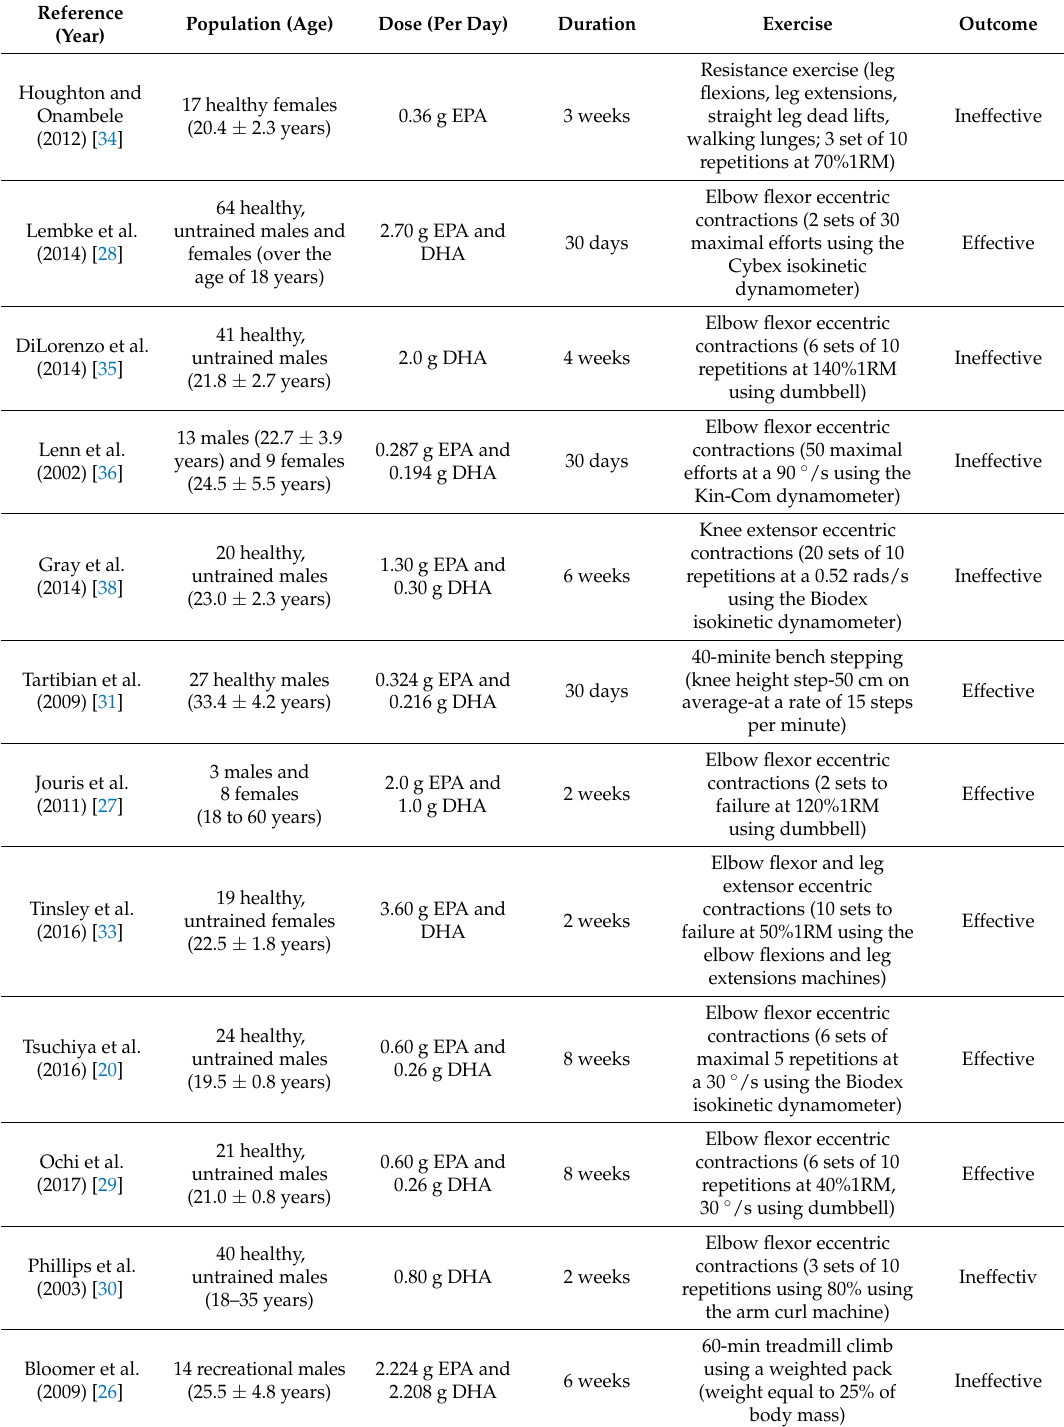
Table 2. Summary of the effects of EPA/DHA supplementation on delayed onset muscle